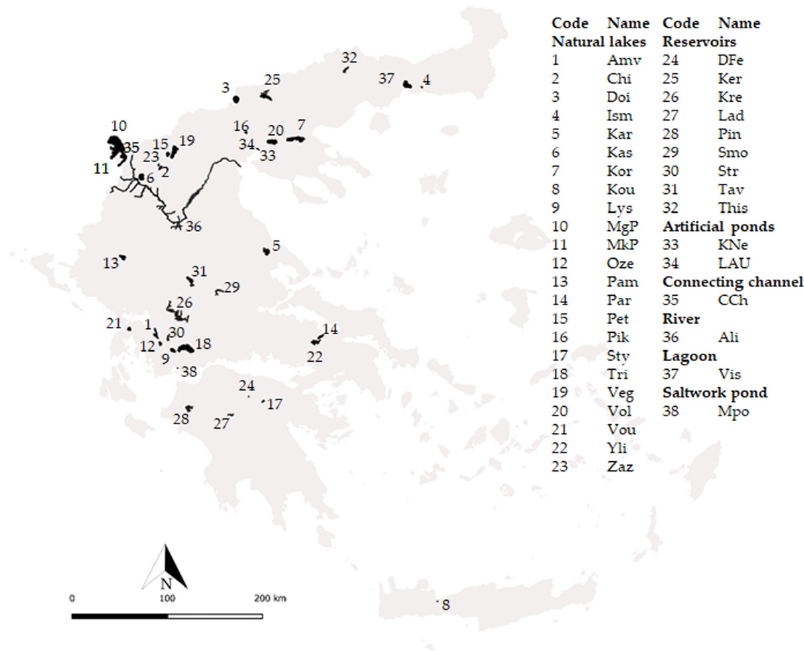
Figure 1. Map of Greece showing the locations of the 38 water bodies included in the study. Abbre- viations: Amv: Amvrakia; Chi: Chimaditida; Doi: Doirani; Ism: Ismarida; Kar: Karla; Kas: Kastoria; Kor: Koronia; Kou: Kournas; Lys: Lysimaxeia; MgP: Megali Prespa; MkP: Mikri Prespa; Oze: Oze- ros; Pam: Pamvotis; Par: Paralimni; Pet: Petron; Pik: Pikrolimni; Sty: Stymfalia; Tri: Trichonis; Veg: Vegoritis; Vol: Volvi; Vou: Voulkaria; Yli: Yliki; Zaz: Zazari; DFe: Doxa-Feneou; Ker: Kerkini; Kre: Kremasta; Lad: Ladona; Pin: Pineiou; Smo: Smokovo; Str: Stratos; Tav: Tavropou; This: Thisavros; KNe: Kipos nerou pond; LAU: Limnoula auth; CCh: Connecting Channel (between the Megali and Mikri Prespa); Ali: Aliakmon; Vis: Vistonis; Mpo: Messolonghi pond.